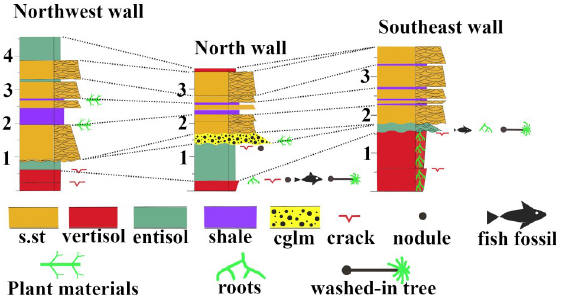
Fig 8. Correlations of the north, northwest, and southeast at the TCHD quarry-walls sediment deposits. The sediment deposits, paleosols, and fossils from the quarry walls, floor and the drill-cores were used to construct the sedimentary profiles. For instance, the information on the depth of the vertisols from the drill-core extracts were included in the profile of the southeast wall. The Northwest wall profile showed more variations as the strike-slip fault made a near 3-D exposure of the wall. Likewise, the quarry floor made it possible to trace the paleosols that made the forest floor as well as the capping sediments from south to north. The fossils included in-situ rooting as well as washed- in fossils such as fish and trees which were helpful in the correlations of the paleosols exposed on the quarry floor. The primary sedimentary structures and the tracing of the sedimentary deposits across the quarry walls made it possible to correlate the sedimentary deposits of the wall. There were four sequences of deposits from base to the top of walls including, trough cross-bedded sandstone, heterolithic bedding, followed by trough cross-bedded sandstone, and paleosols, respectively that varied in their thickness between the walls.